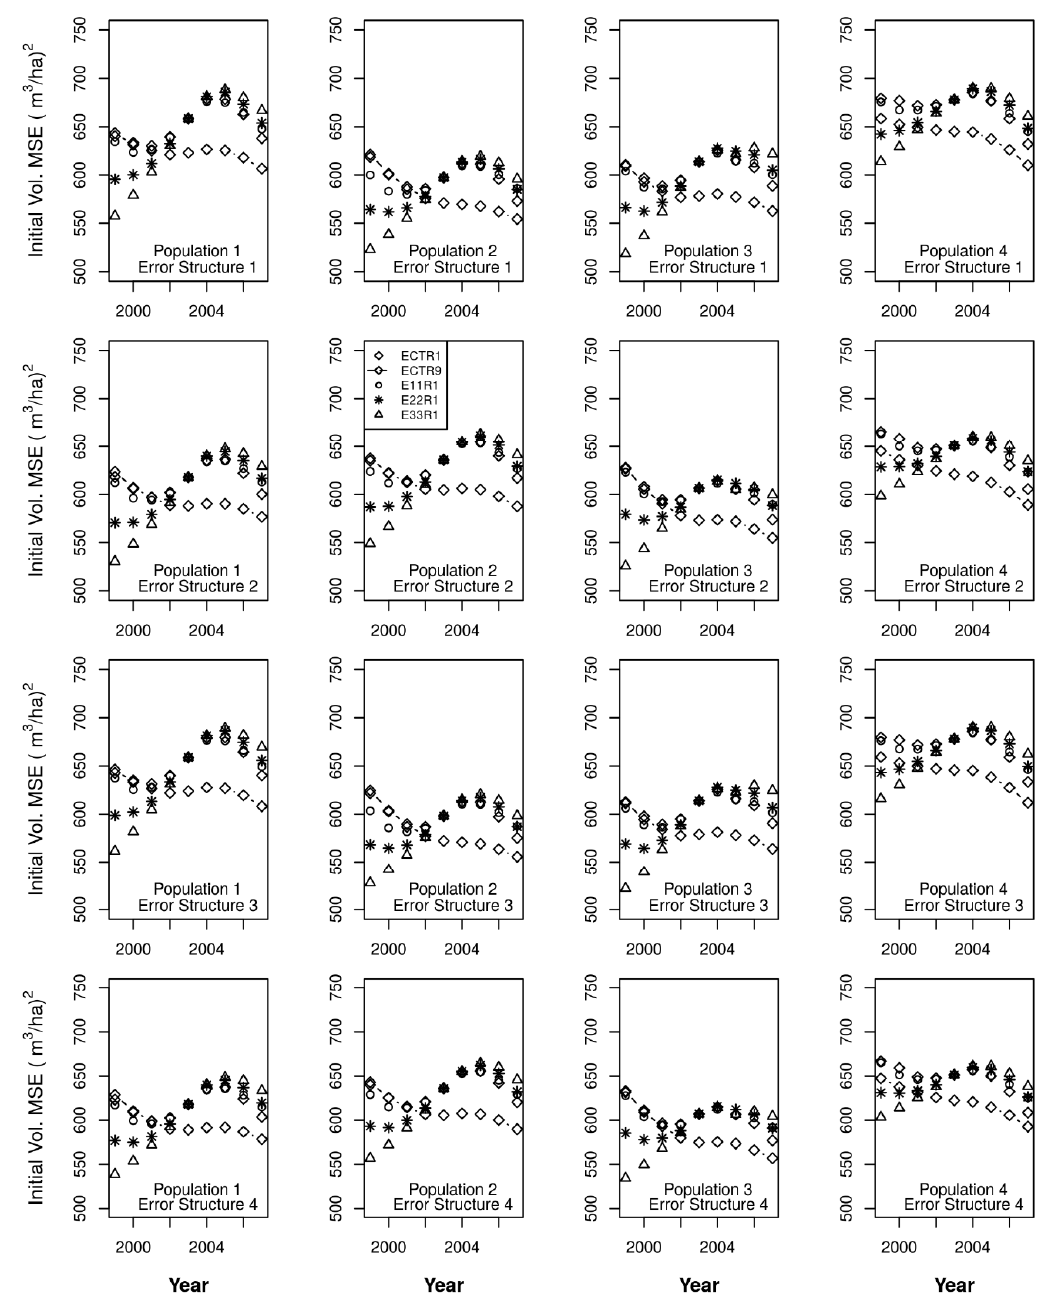
Figure 6. The means of the initial volume estimators relative to the population initial volumes over 1000 iterations of 1000 samples for each population and sample error structure.